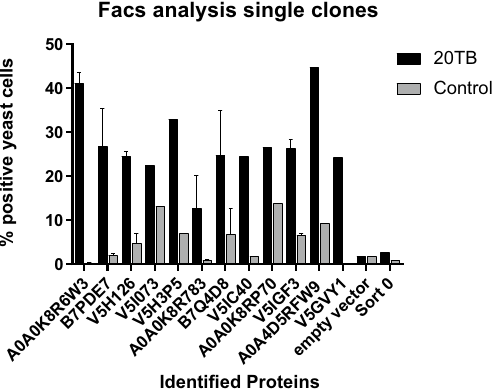
Figure 2. Validation of identified Tick Salvary Gland Poteins (TSGPs) through FACS analysis of isolated yeast cell clones. Antibody binding to single yeast cell clones expressing the respective TSGP probed with 50 µg/ml of 20 TB IgG or control IgG. When available, multiple clones per TSGP were used. Columns depict the mean percentage of Xpress and human IgG positive cells, error bars show the standard error of the mean.